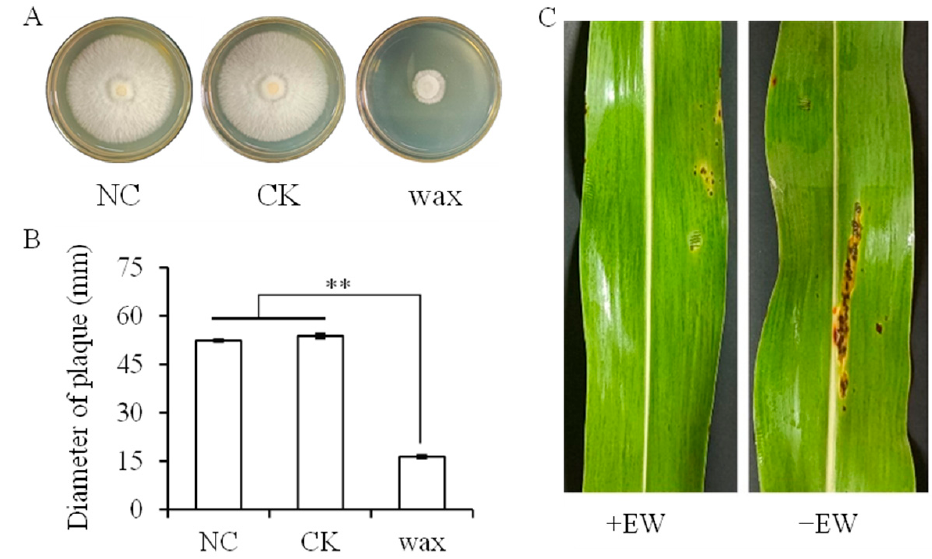
Figure 1. Diameters of anthracnose ( Colletotrichum sublineola ) colonies ( A , B ) on PDA medium amended with water (negative control, NC), chloroform (CK), or chloroform containing leaf wax (wax) and symptoms of sorghum leaves inoculating anthracnose remaining and removing epicuticu- lar wax at 3 dpi ( C ). Bars with two stars (**) represent significance at p = 0.01 level according to least significant different test by a one-way analysis of variance with Duncan’s multiple range test ( n = 6); +EW and − EW indicate remaining and removing epicuticular wax, respectively.